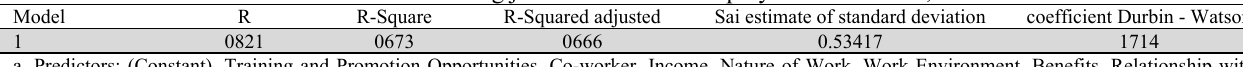
The results of statistical values of factors affecting job satisfaction of employees’ accountant, auditors Model R R-Square R-Squared adjusted Sai estimate of standard deviation